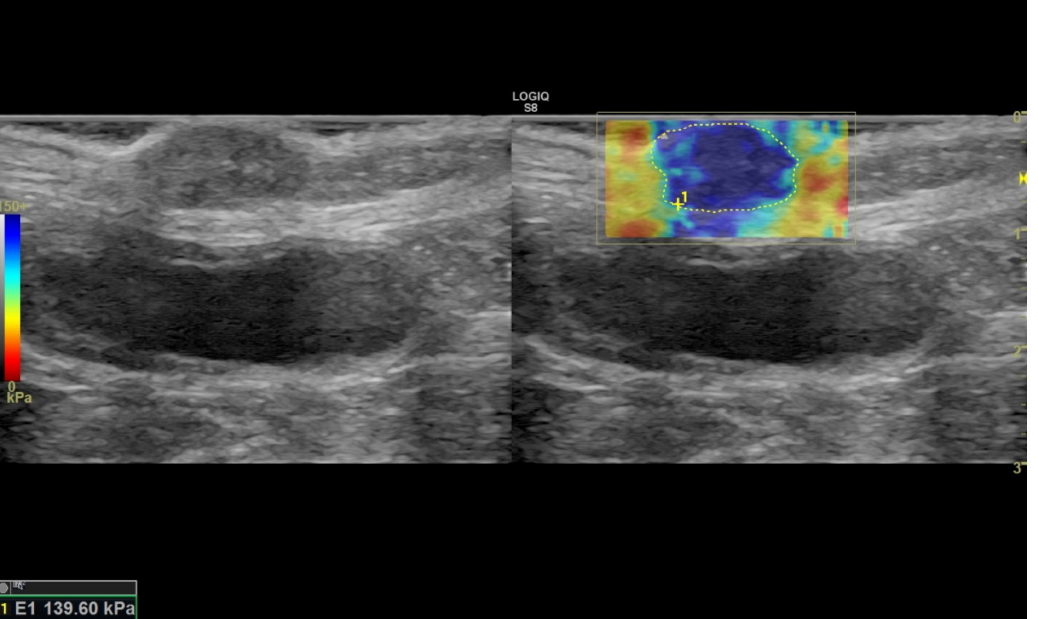
Figure 2. A representative image of the quantitative measurement of SWE-S in a mammary nodular lesion in a bitch was included in the study (sample No. 17). The graduation red-to-blue scales reported on the left of the image refer to the degree of stiffness. The region of interest (ROI) is delimitated by discontinuous yellow line